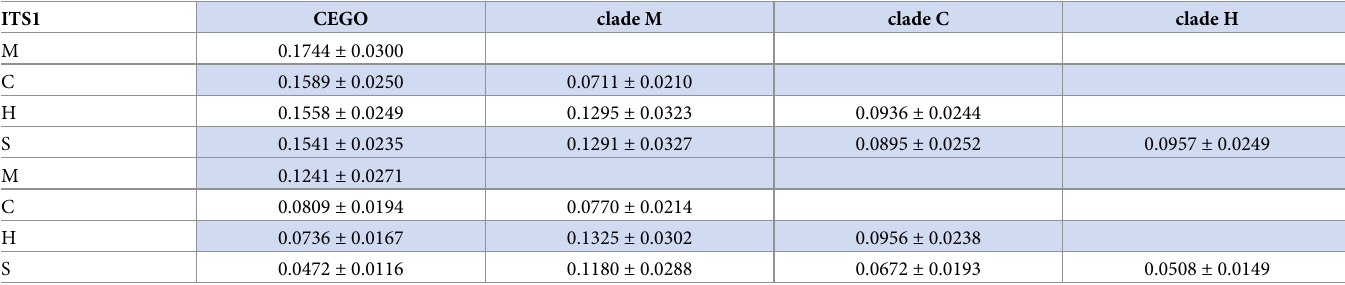
Table 2. Between group mean genetic distances of ITS1 and ITS2 regions. ITS1